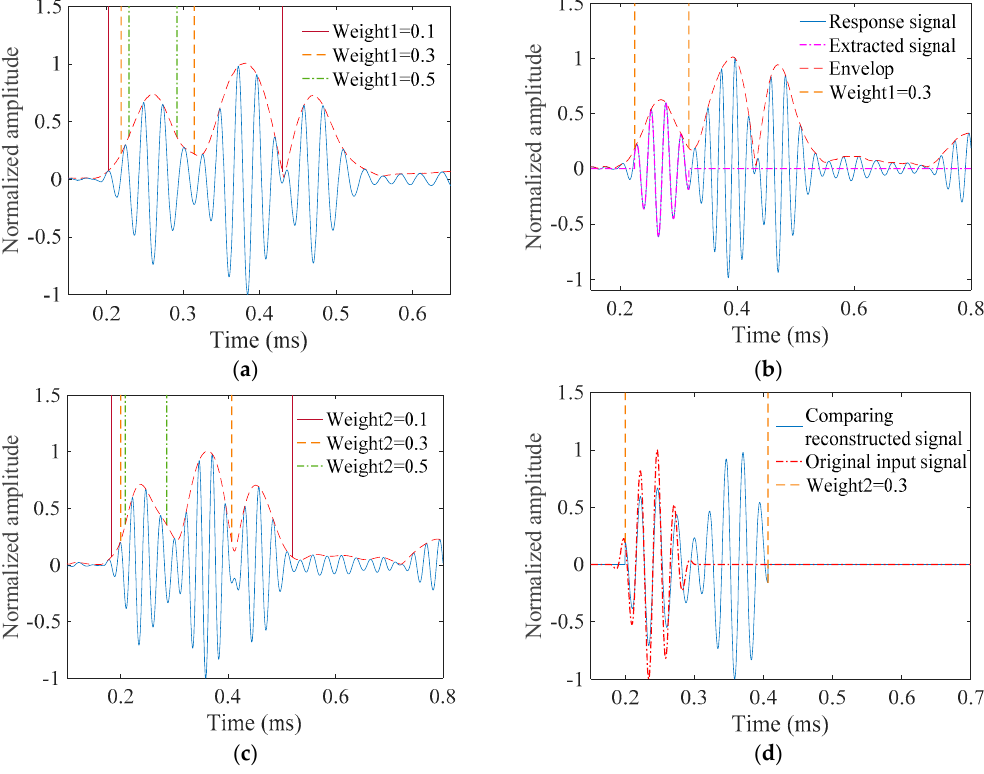
Figure 5. ( a ) The time interval for extracting re-emitted components varies with weight1 ; ( b ) the extract re-emitted components when weight1 = 0.3 ; ( c ) the time interval for extracting reconstructed components varies with weight2 ; and ( d ) the comparison between the reconstructed components and the original input signal when weight2 = 0.3 .